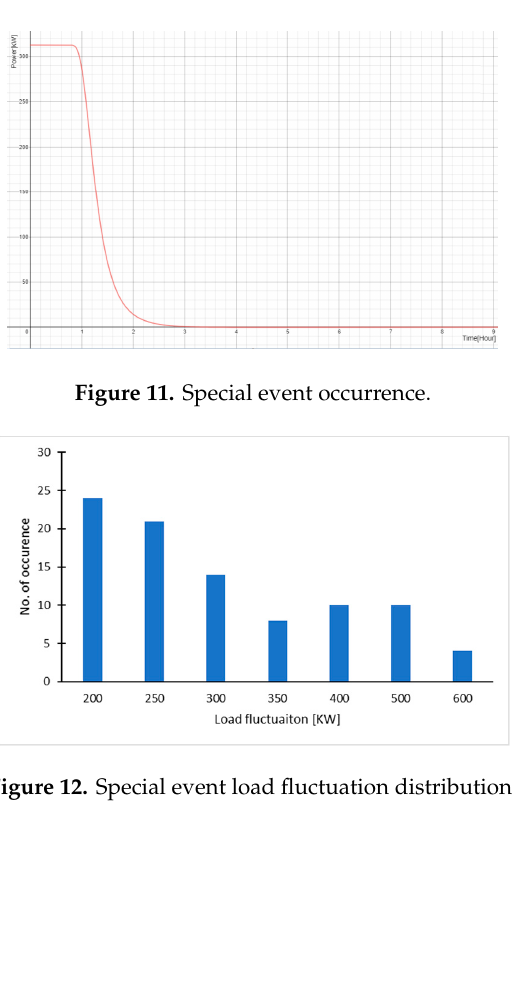
Figure 13. Special duration distribution.